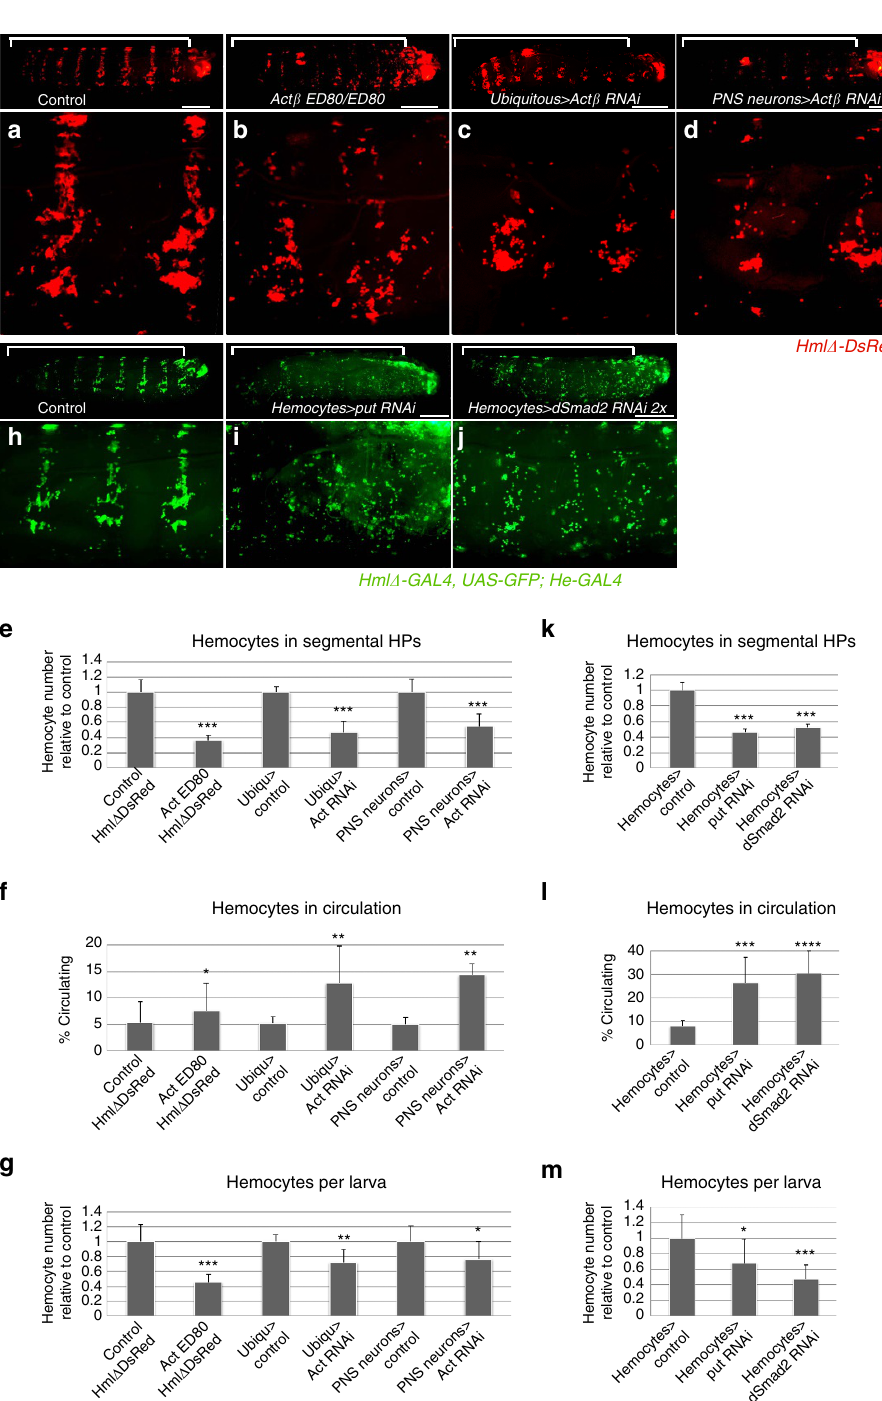
Figure 2 | Loss of Activin- b /dSmad2 signalling results in hemocyte defects. ( a – d ) Loss of Act b in neurons affects hemocytes, lateral view of larvae (top panels) with close-up (lower panels). ( a ) Control Hml D -DsRed / þ ( b ) Act b mutant, Hml D -DsRed/ þ ; Act b ED80/ED80 . ( c ) Act b RNAi silencing with ubiquitous driver Actin5C-GAL4 . ( d ) Act b RNAi ( UAS-Act RNAi Vienna GD) silencing in PNS neurons, md neuron specific driver 21-7-GAL4 . ( e ) Hemocyte counts in segmental HPs (bracketed areas in a – d top panels), n ¼ 4–7 per genotype. ( f ) Fraction of circulating hemocytes, n ¼ 4 to 8 per genotype. ( g ) Total hemocyte counts per larva, n ¼ 4 to 8 per genotype. In e – g experiment numbers relative to matching control cohorts, genotypes Hml D -DsRed/ þ ; Act b ED80/ED80 (matching control: Hml D -DsRed/ þ ); Actin5C-GAL4, Hml D -DsRed/ þ ; UAS-Act b RNAi/ þ (matching control: Actin5C-GAL4, Hml D -DsRed/ þ ) ; 21-7-GAL4, UAS-mCD8GFP, Hml D -DsRed/ þ ; UAS-Act b RNAi / þ (matching control: 21-7-GAL4, UAS-mCD8GFP, Hml D -DsRed/ þ ). Hemocyte numbers were assessed in larvae 64–75h AEL (2.2–2.6mm) ( h – j ) Hemocyte-specific RNAi silencing of Act b pathway components, driver Hml D -GAL4, UAS-GFP; He-GAL4 . Top panels whole larva lateral view, lower panels closeups. ( h ) Control; ( i ) UAS-put RNAi; ( j ) UAS-dSmad2 RNAi. ( k ) Hemocyte counts in segmental HPs (bracketed areas h - j in top panels), n ¼ 4 to 7 per genotype. ( l ) Fraction of circulating hemocytes, n ¼ 7 to 10 per genotype. ( m ) Total hemocyte counts per larva, n ¼ 7 to 11 per genotype; larvae 53–60h AEL (1.8–2.0mm). In ( k – m ) experiment numbers relative to matching control cohorts are shown; genotypes Hml D -GAL4, UAS-GFP/ þ ; He-GAL4/ þ (control); Hml D - GAL4, UAS-GFP/ þ ; He-GAL4/UAS-put RNAi or Hml D -GAL4, UAS-GFP/UAS-dSmad2 RNAi; He-GAL4/ þ (experiment). Scale bars:, a – d and i , j 0.5mm. Error bars represent s.d., and two-tailed t -test values correspond to NS (not significant) P 4 0.05; * P r 0.05; ** P r 0.01; *** P r 0.001; **** P r 0.0001. NATURE COMMUNICATIONS|8:15990|DOI: